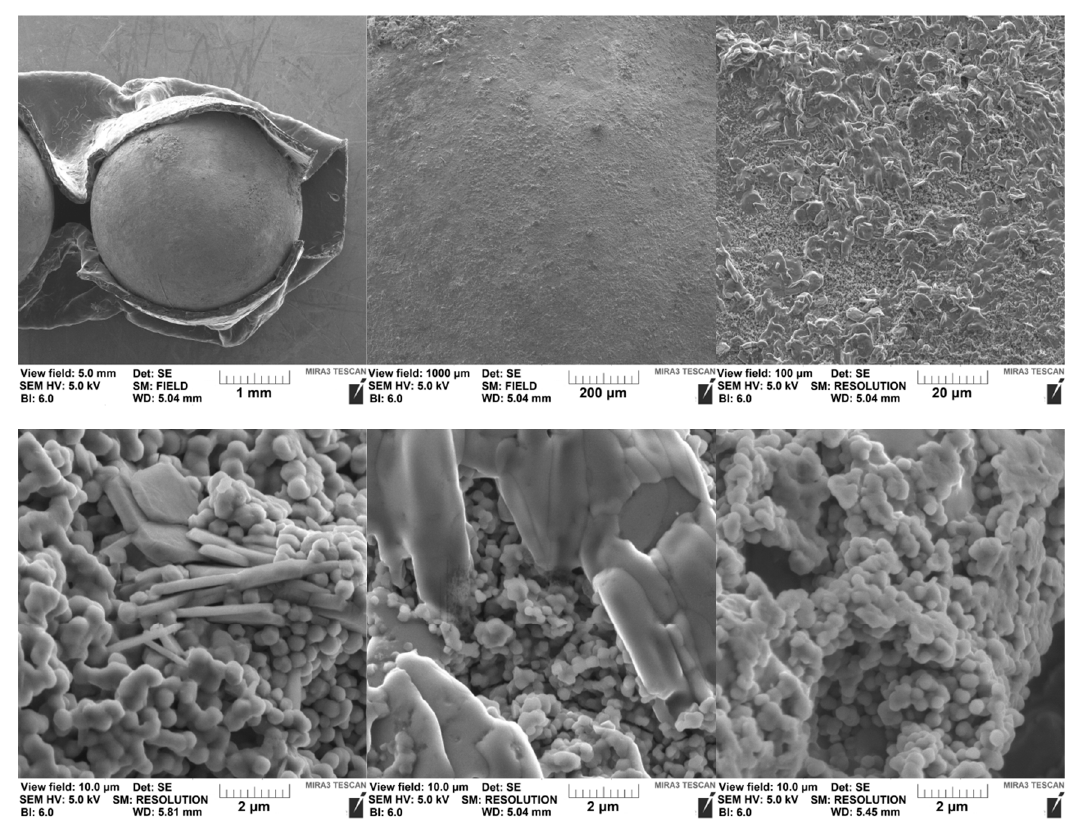
Figure 4. Micrographs of the surface of the titanium hydride shot modified under dynamic conditions in the presence of NH 4 OH (pH = 4–5).